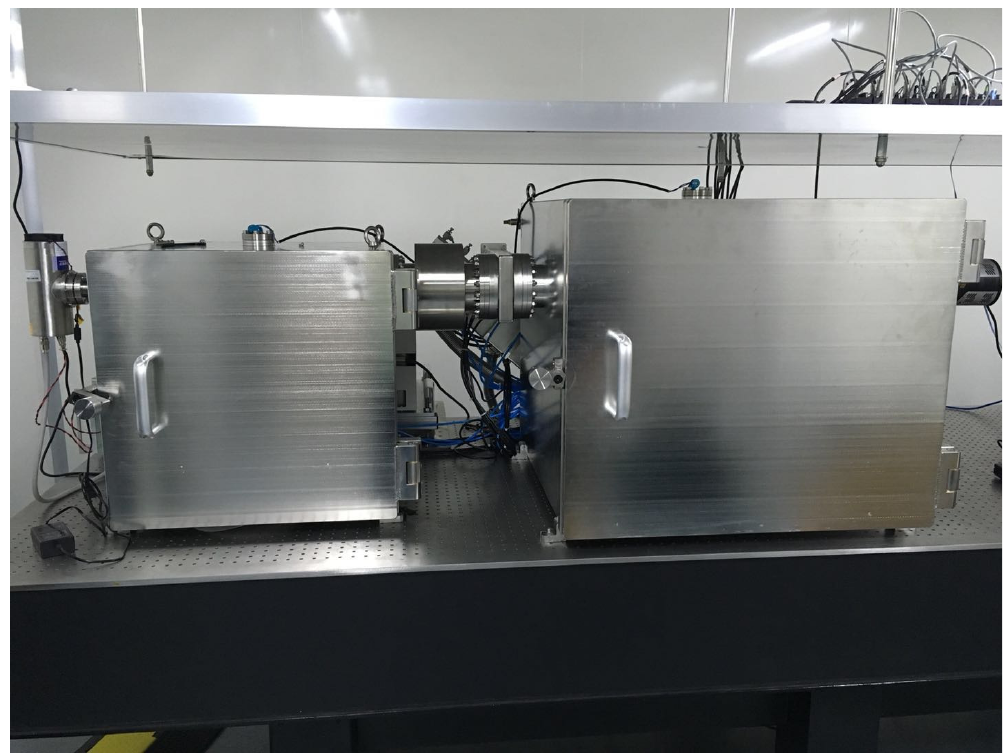
Figure 7. A photograph of the tabletop X-ray GISC microscope facility in